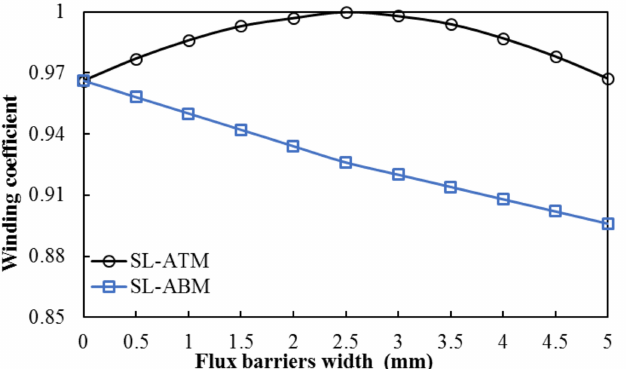
Figure 3. Winding coefficient versus flux barrier width for machines.